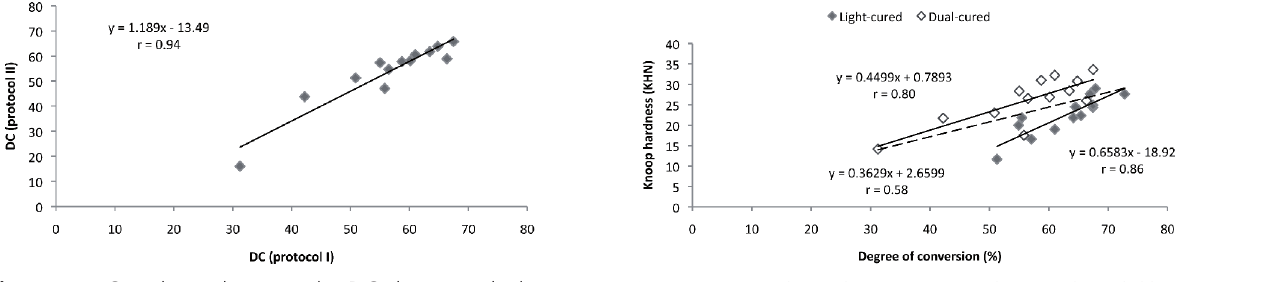
Figure 2 - Correlation between DC and KNH. The solid lines are individual regressions to light- and dual-cured cements. The dashed line indicates the regression for all data points.